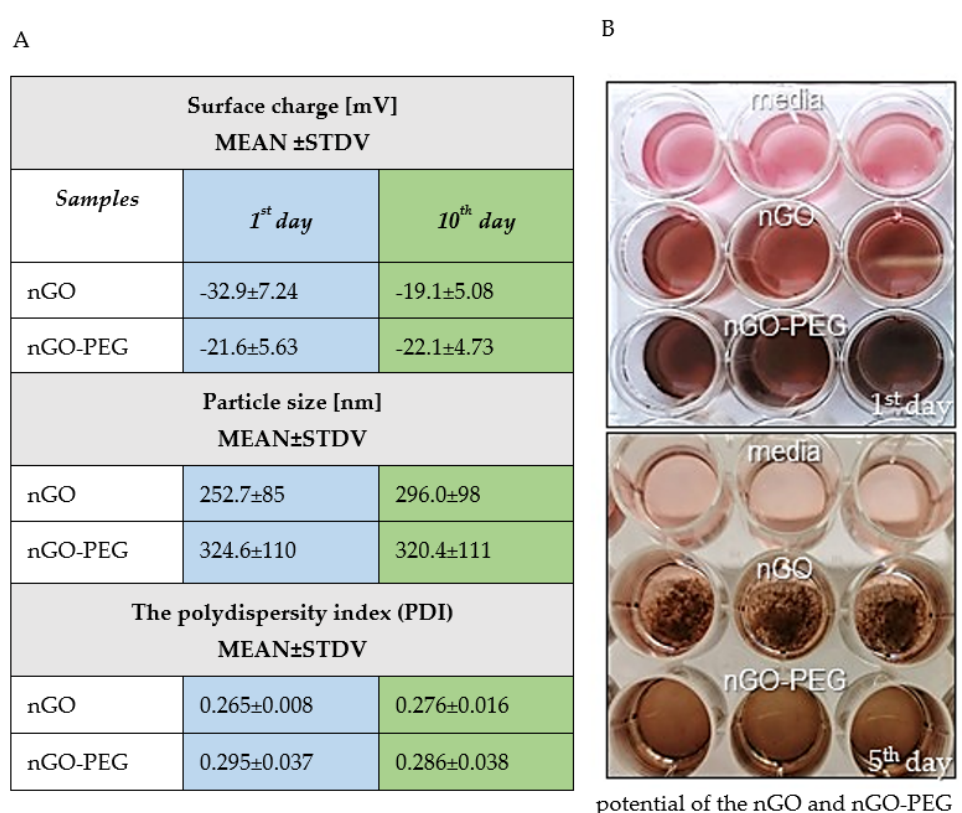
Figure 3. Stability and aggregation behaviour of nGO and nGO-PEG nanoparticles in aqueous and culture media solutions. ( A ) Dynamic light scattering (DLS) experiments for studying the colloidal stability of nGO and nGO-PEG in water: zeta potential, size measurements, and polydispersity index (PDI) of nGO and nGO-PEG for 10 days in aqueous solution. Three independent measurements have been done and the results are represented as MEAN ± STDV. ( B ) Aggregation analyses of nGO and nGO-PEG in complete cell culture media after five days of incubation under optimal culturing conditions. Images are taken on the first and fifth days with Nikon D700 camera.